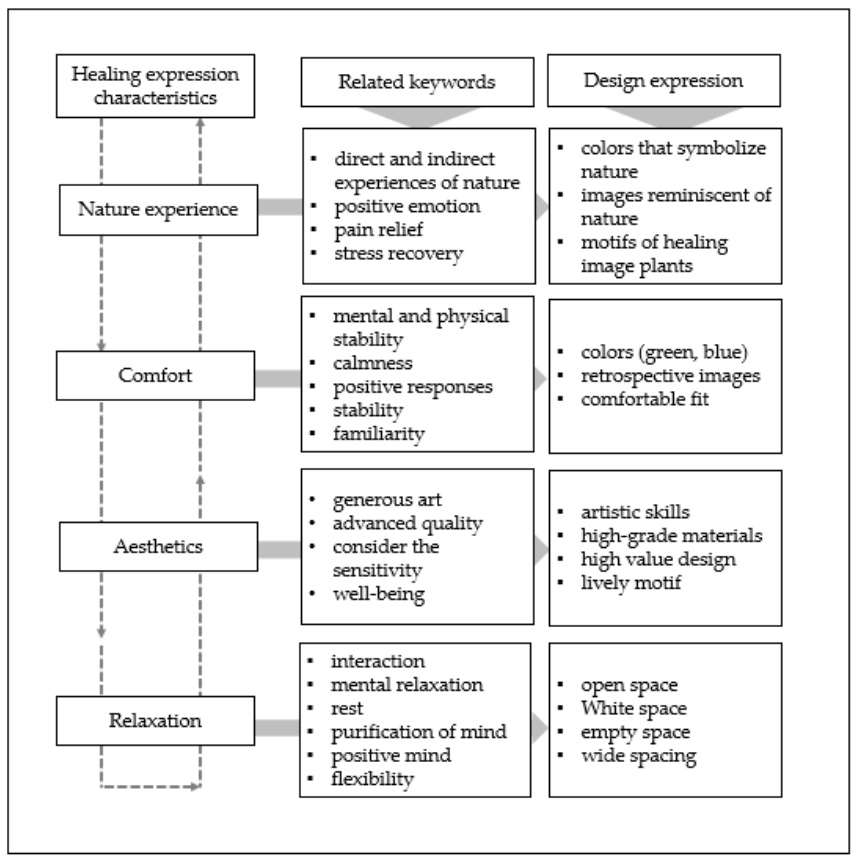
Figure 3. Summary of the design expression characteristics that influence healing through literature review studies .